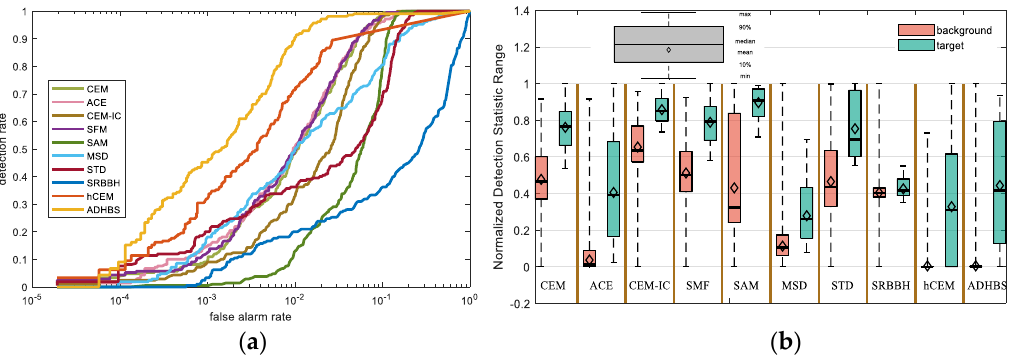
Figure 16. ( a ) The ROC curve comparison for the Okavango Delta data. ( b ) The separability map for the Okavango Delta data. Table 1. Area under the ROC curves (AUC) value comparison for three datasets (keep four decimal places). Datasets Algorithms